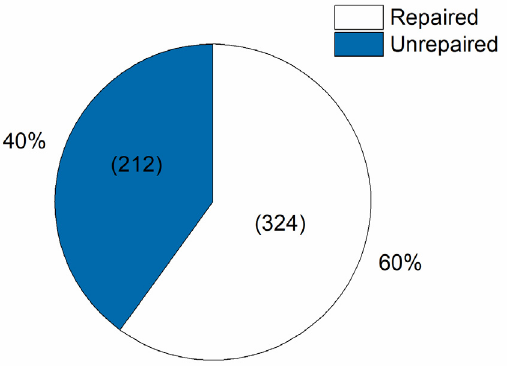
Figure 8. Number of ventilators repaired and not repaired at Reference Unit.